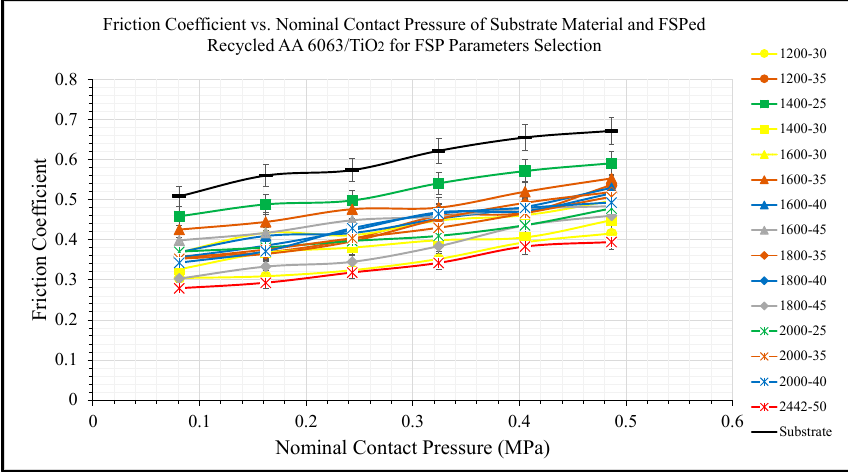
Friction Coefficient vs. Nominal Contact Pressure of Substrate Material and FSPed Recycled AA 6063/TiO 2 for FSP Parameters Selection Figure 17. Friction coefficient against nominal contact pressure for substrate material and FSPed samples at a sliding speed of 5.18 m/s for a test duration of 120 s under starved lubrication